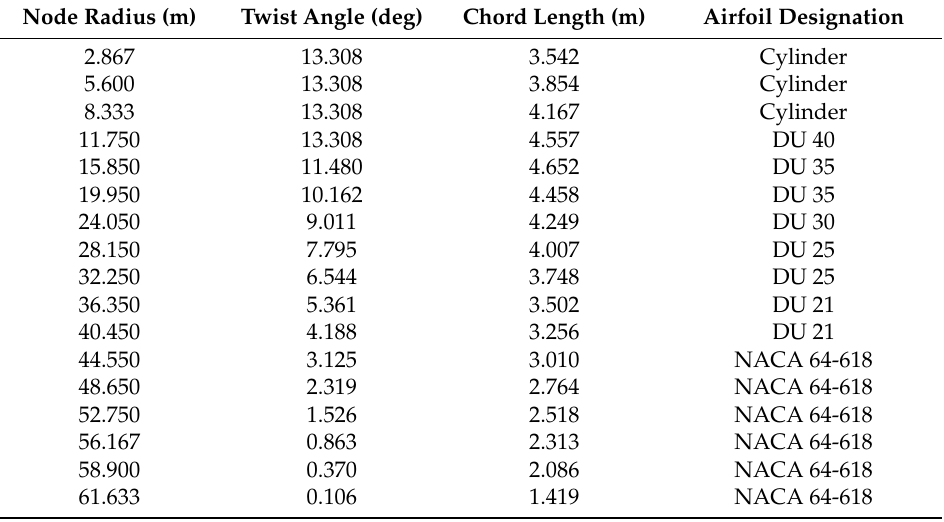
Figure 1. Airfoil construction of National Renewable Engineering Lab (NREL) 5 MW blade. Table 3. Blade airfoil distribution of National Renewable Engineering Lab (NREL) 5 MW wind turbine.